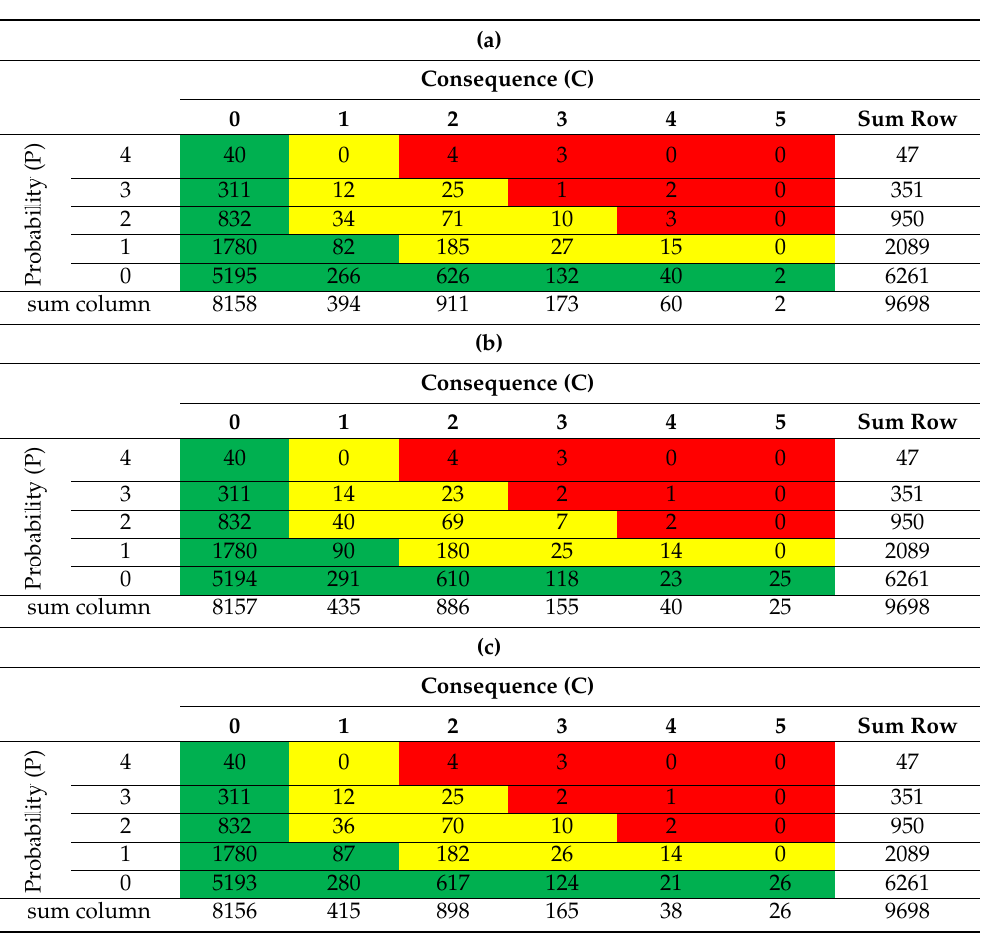
Table 7. Risk matrices of pipes based on their combined failure probability and consequences for service scenarios ( a ) J, ( b ) B, and ( c ) both J and